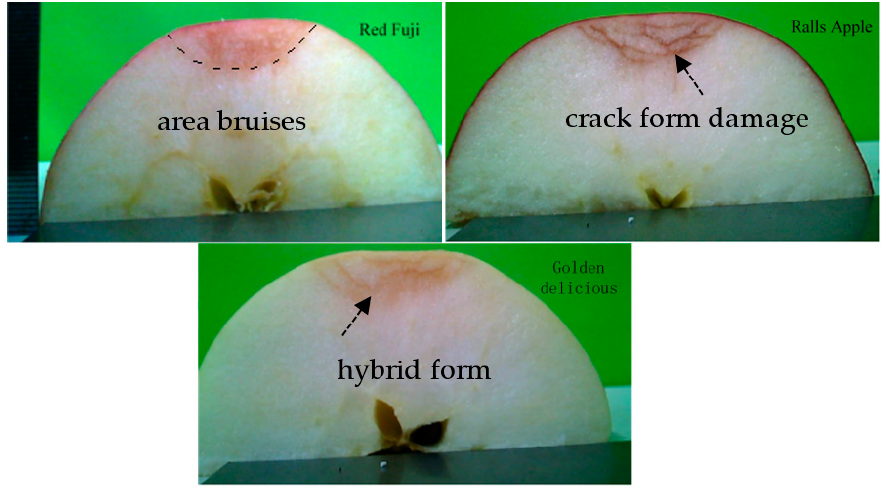
Figure 8. Damage morphology of different apple varieties under a pressing distance of 6 mm and a speed of 2 mm/s.